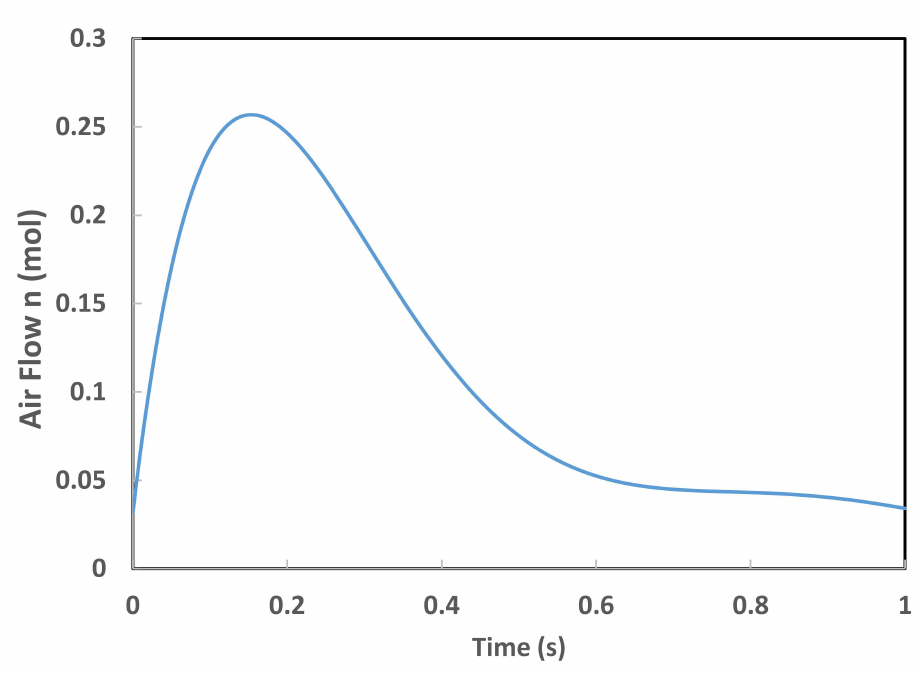
Figure 6. Airflow versus